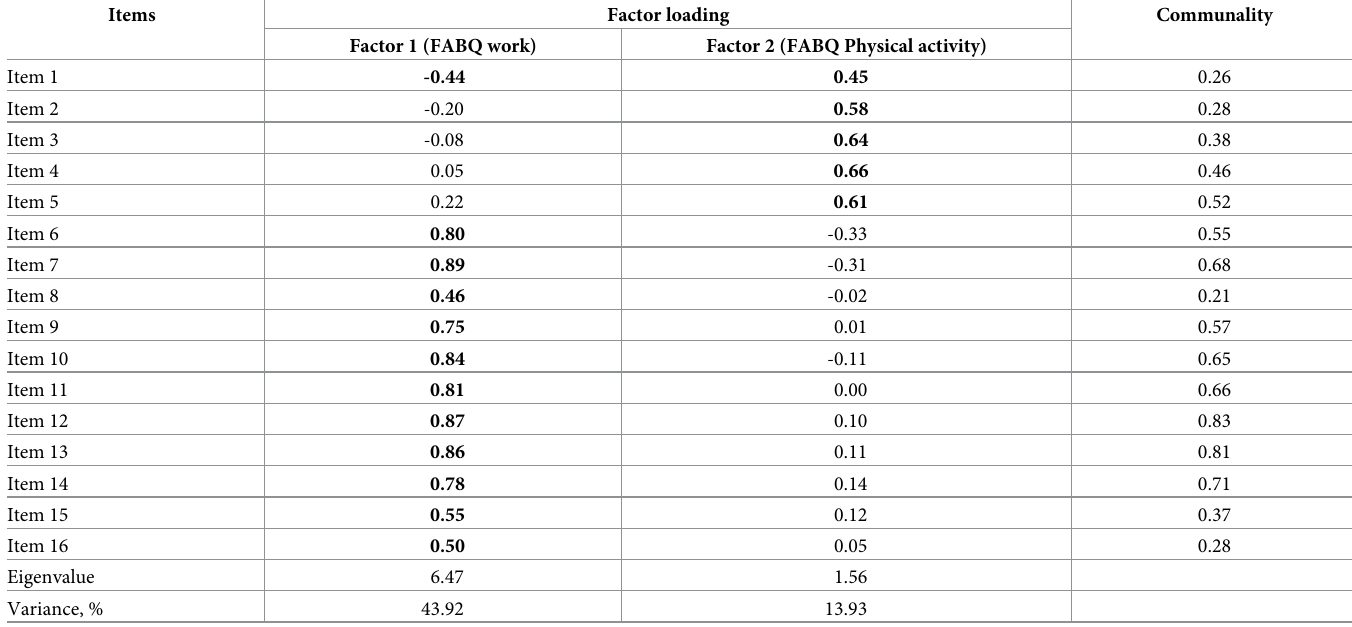
Table 2. Exploratory factor analysis of Fear-Avoidance Beliefs Questionnaire (n =